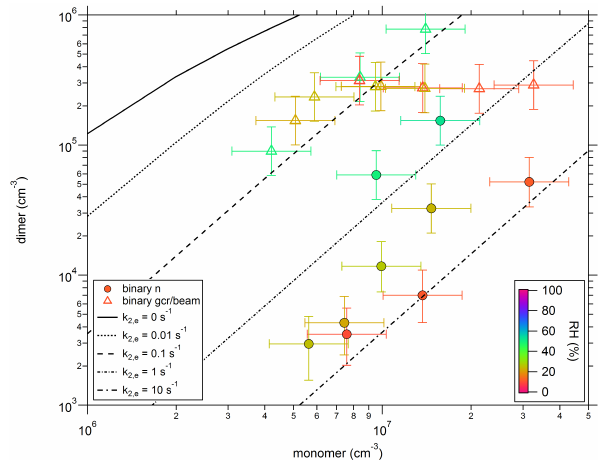
Figure 5. Same as Fig. 4 but for a temperature of 223K. Figure 6. Dimer evaporation rate as a function of the RH for two different temperatures (208 and 223K). Power law fit curves are shown and the slopes p are indicated in the figure